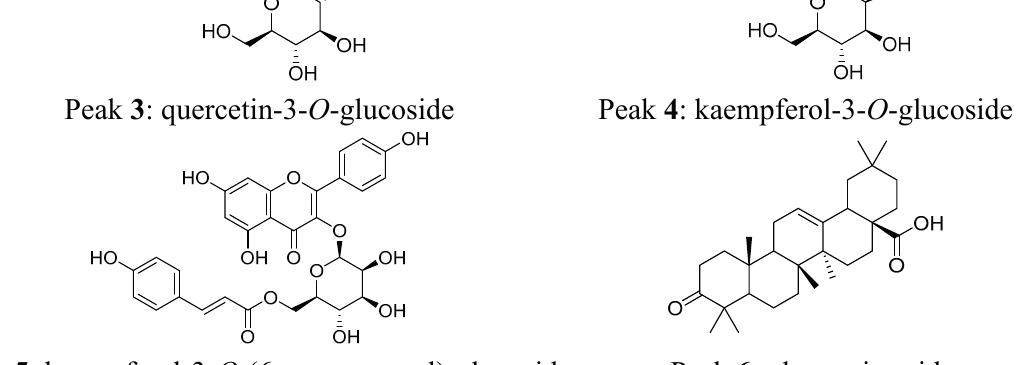
Peak 5 : kaempferol-3- O -(6- p -coumaroyl)-glucoside Peak 6 : oleanonic acid